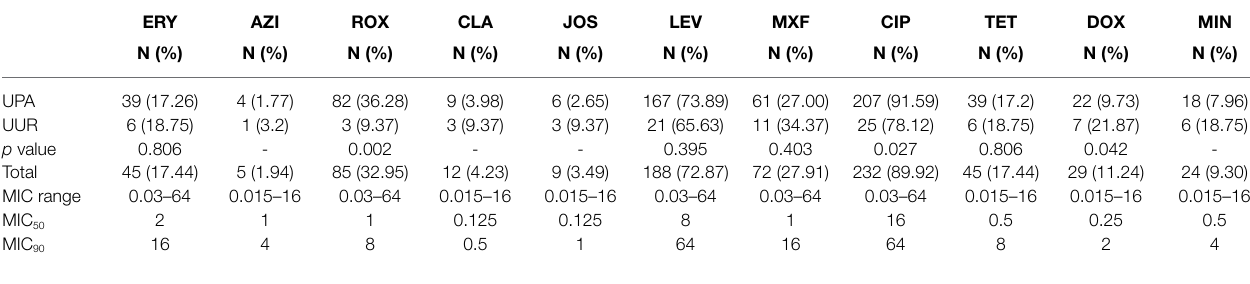
TABLE 4 | Occurrence of ROX-CIP and MDR among Ureaplasma spp. Ureaplasma spp. (N